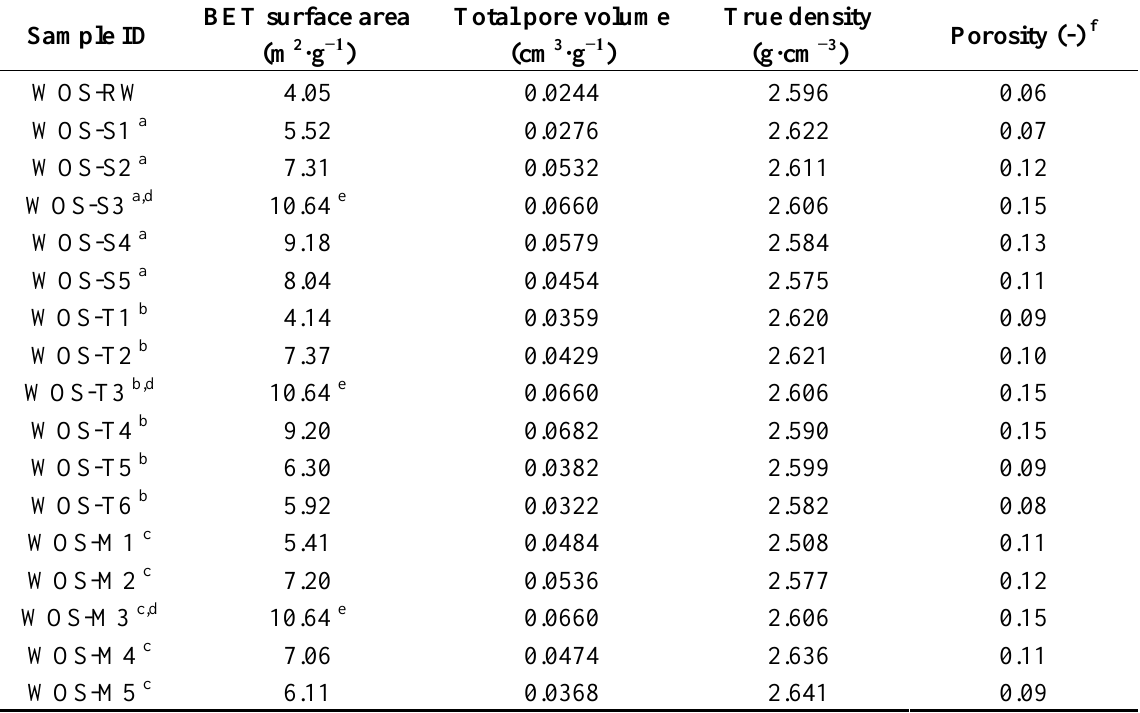
Table 2. Physical characterization of the crude oyster shell powder (denoted as WOS-RW) and the calcite-based mineral powders (denoted as